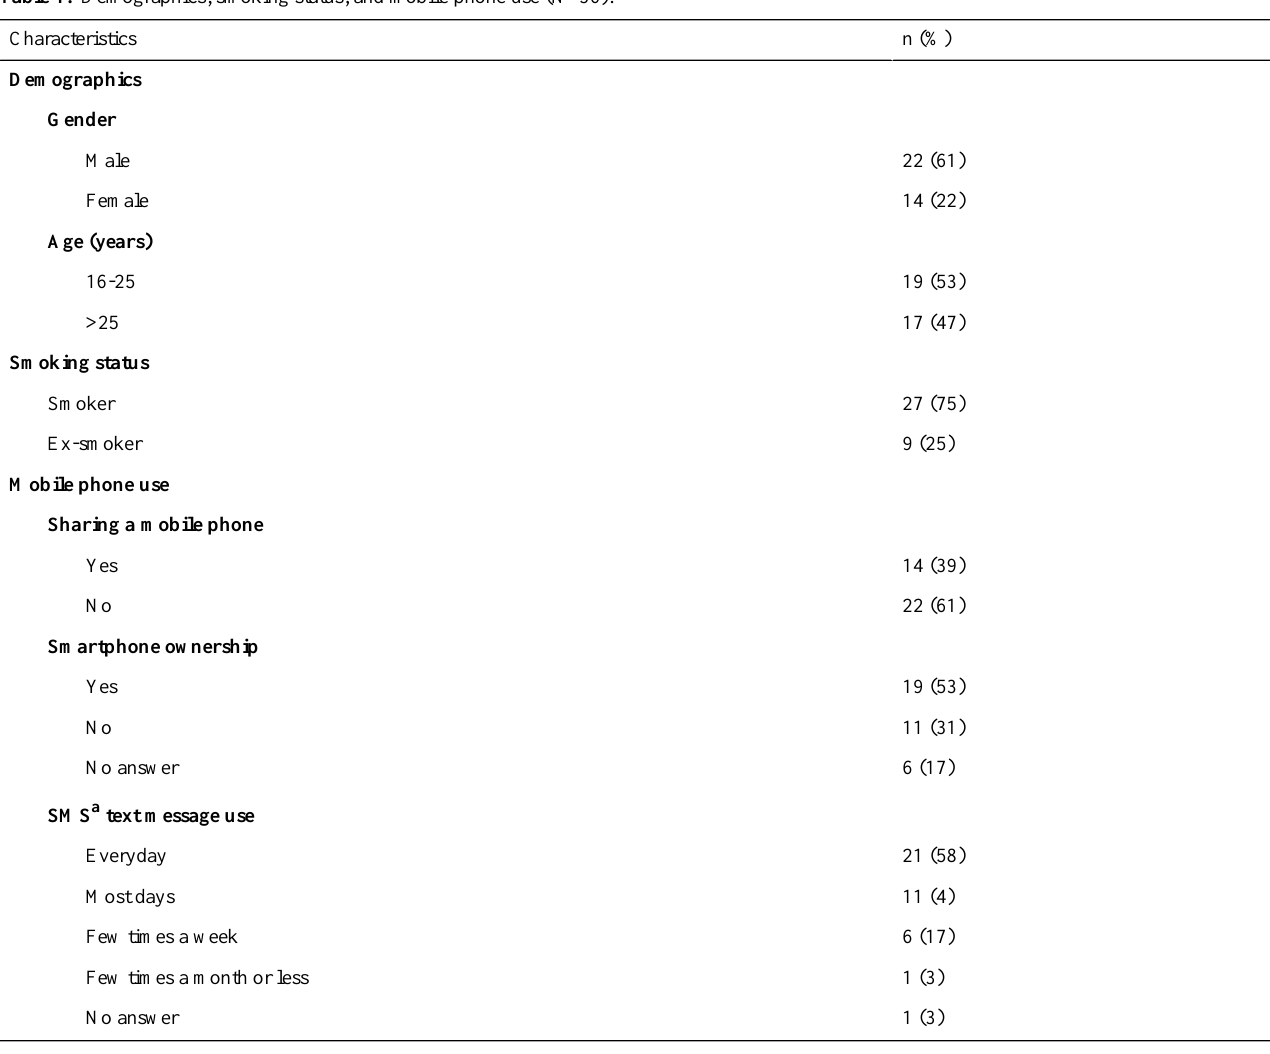
Table 1. Demographics, smoking status, and mobile phone use (N=36).